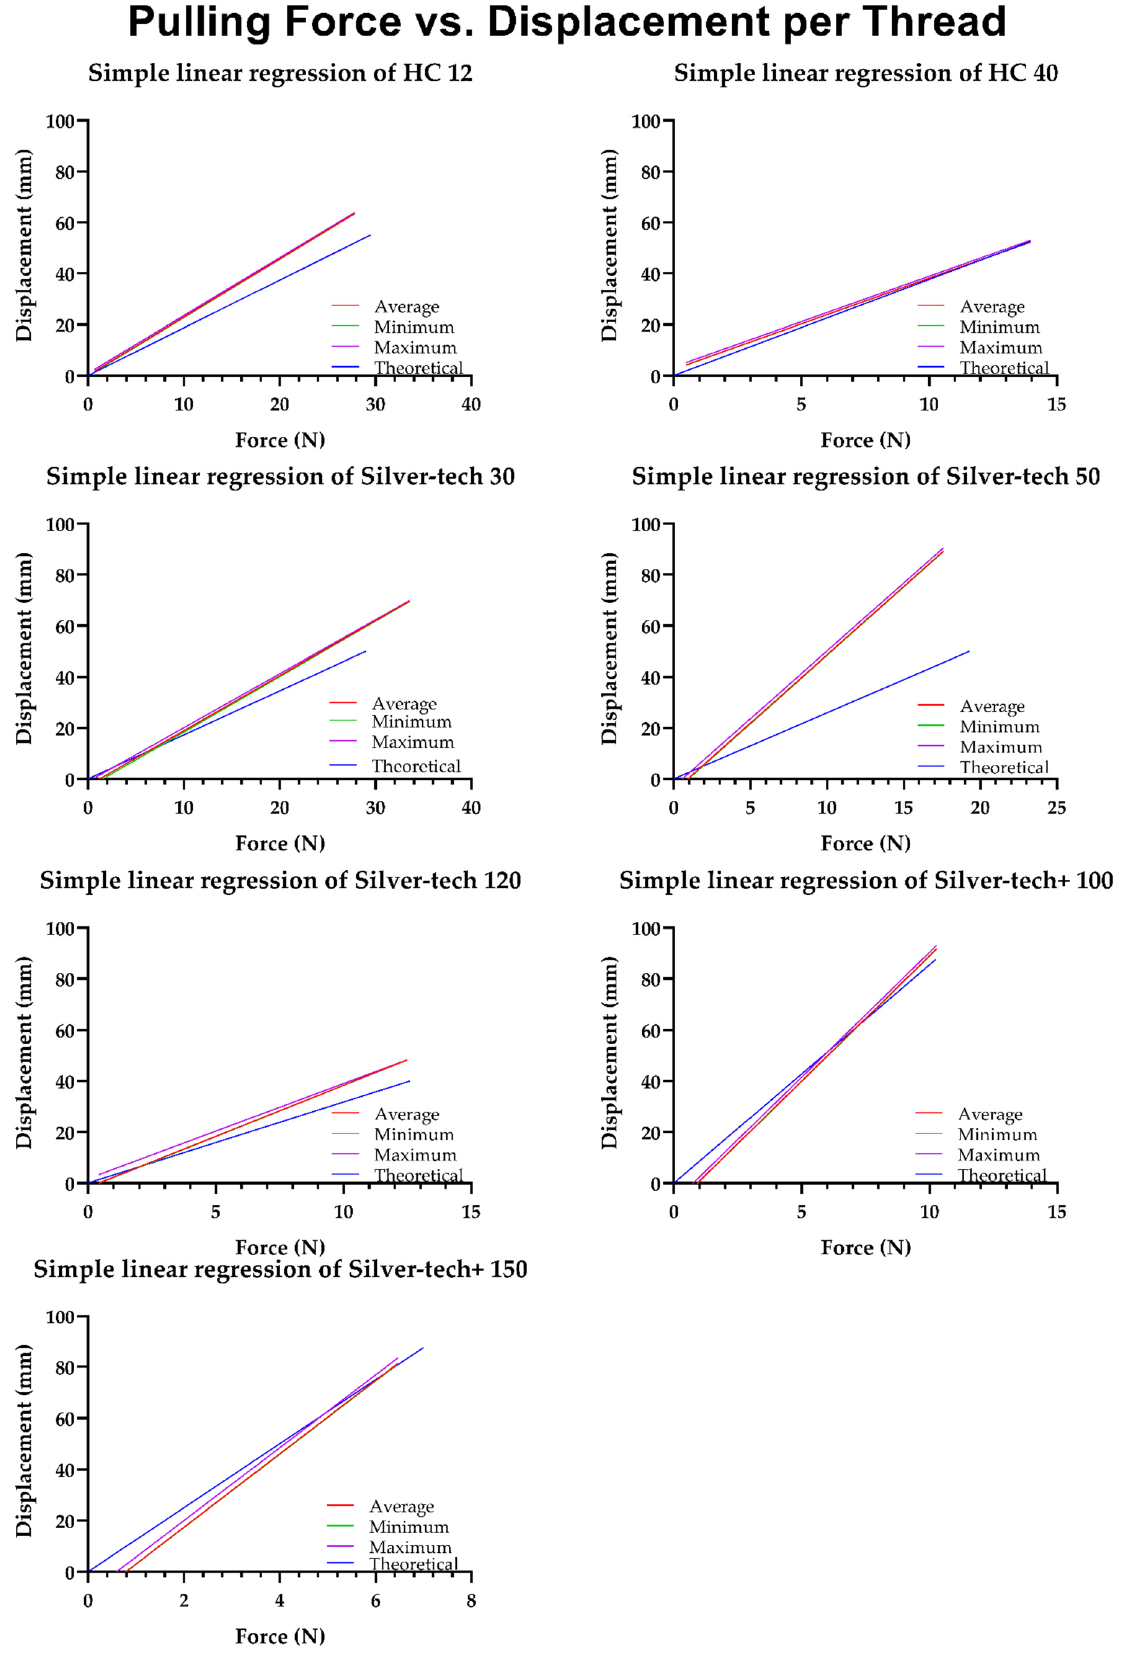
Figure 2. Linear regressions and theoretical line plots of the force–displacement relationship per thread type.